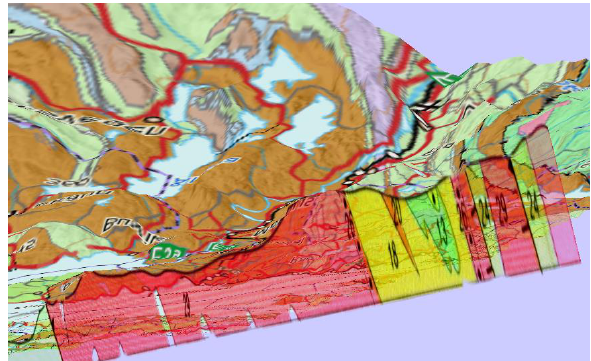
Figure 13: A geological profile projected into 3D space